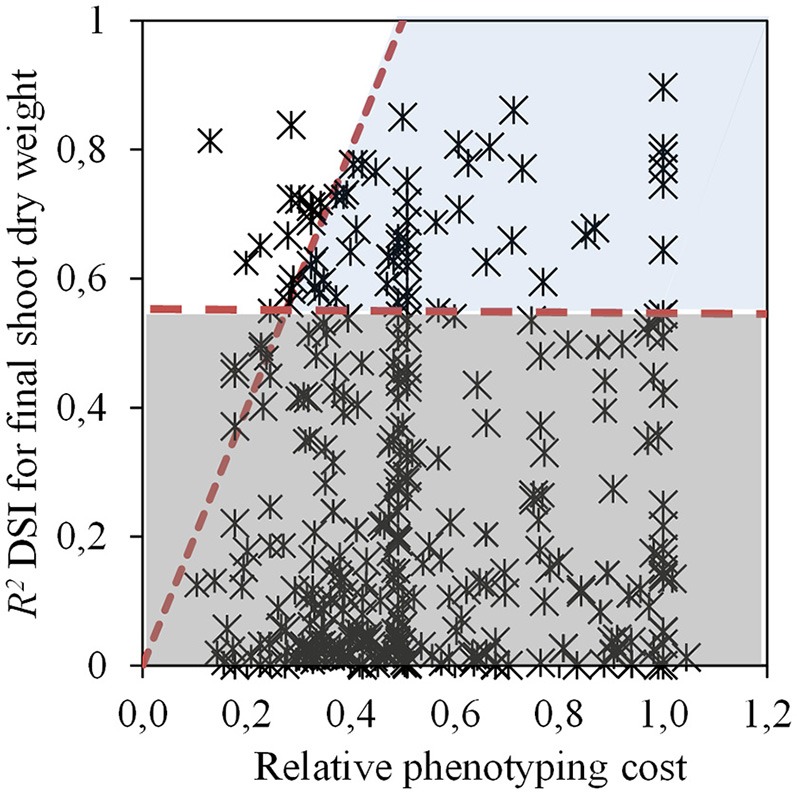
Determination coefficient (R2) of the relationship between drought susceptibility index (DSI) for shoot dry weight at 57 DAE and a given trait vs. relative phenotyping cost (calculated as the phenotyping cost of each trait divided by the cost of DSI for shoot dry weight). Horizontal dash line indicates the threshold for significant regressions. Diagonal dash line indicates the threshold of the ratio of the determination coefficient of the relationship of DSI for shoot dry weight to the relative phenotyping cost. White section shows the significant and selectable relationships (p < 0.05), the dark gray section of the figure exhibit the non-significant relationships (p > 0.05) while the light gray area displays the traits discarded for having a ratio between the determination coefficient and the relative phenotyping cost, lower than 2. Data from Experiment 1.